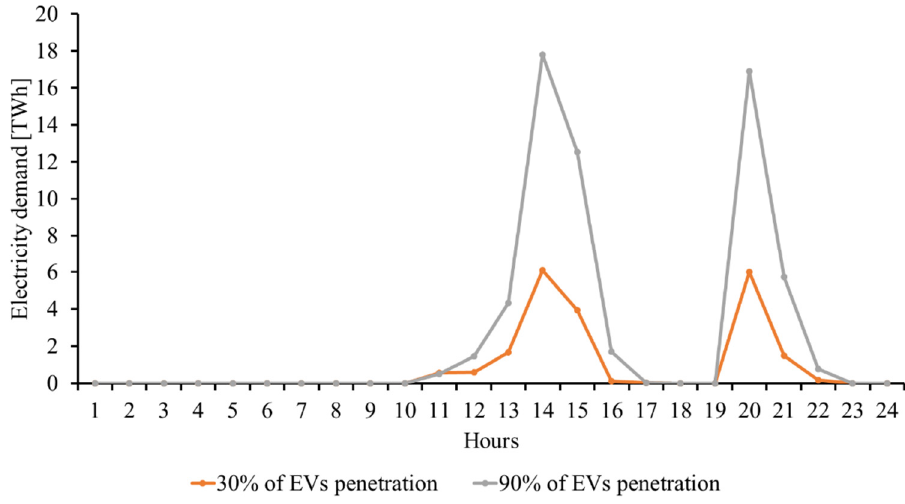
Figure 8. Daily forecasted electricity demand for 30% and 90% EVs penetration.